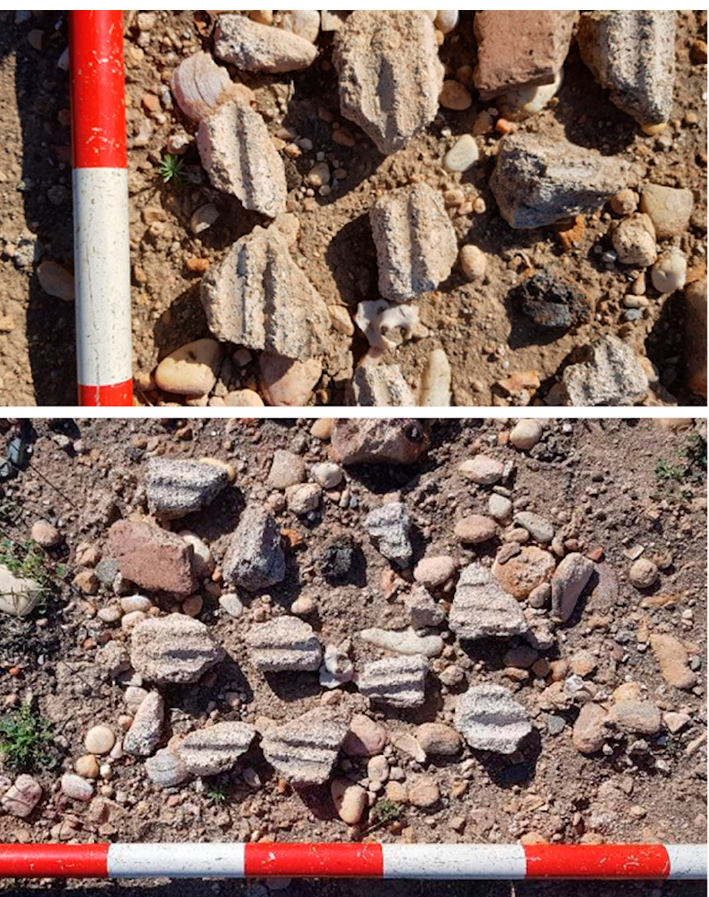
Figure 6. Documentation of the roof through the imprints of the reeds 2.2. Hydraulic structures and their context (Zone A: Area 2) .